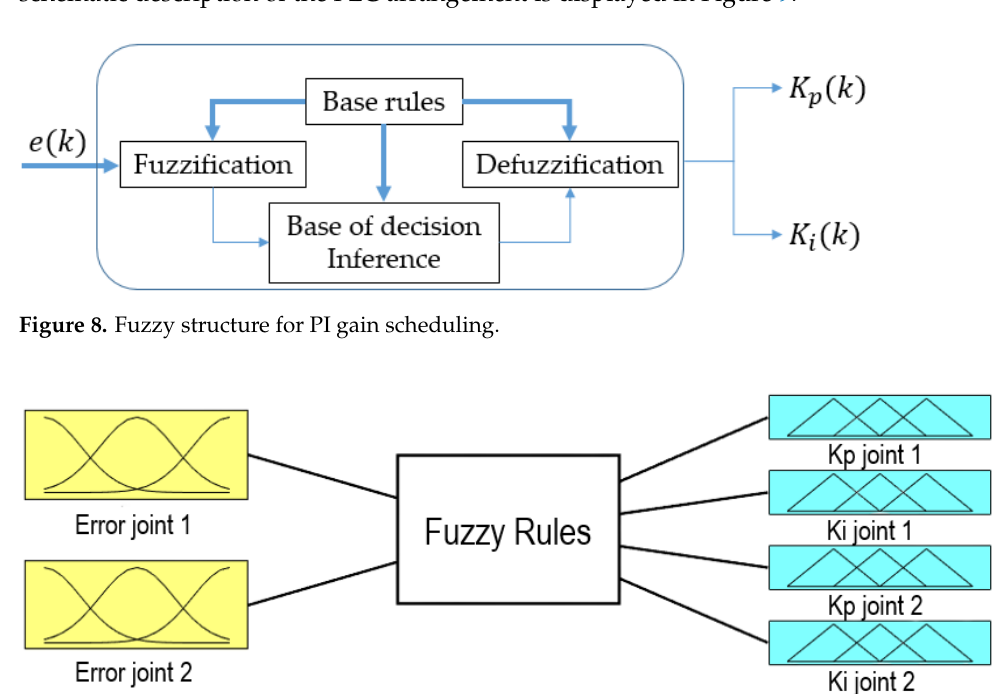
Figure 9. Fuzzy controller configuration within inputs and outputs.